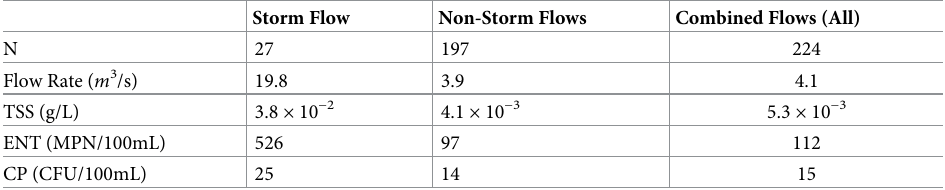
Table 3. Mean historical storm, non-storm and combined flow rates, and TSS and bacterial concentrations. Com- bined flows consider the entire historical record. CFU is colony forming units. MPN is most probable